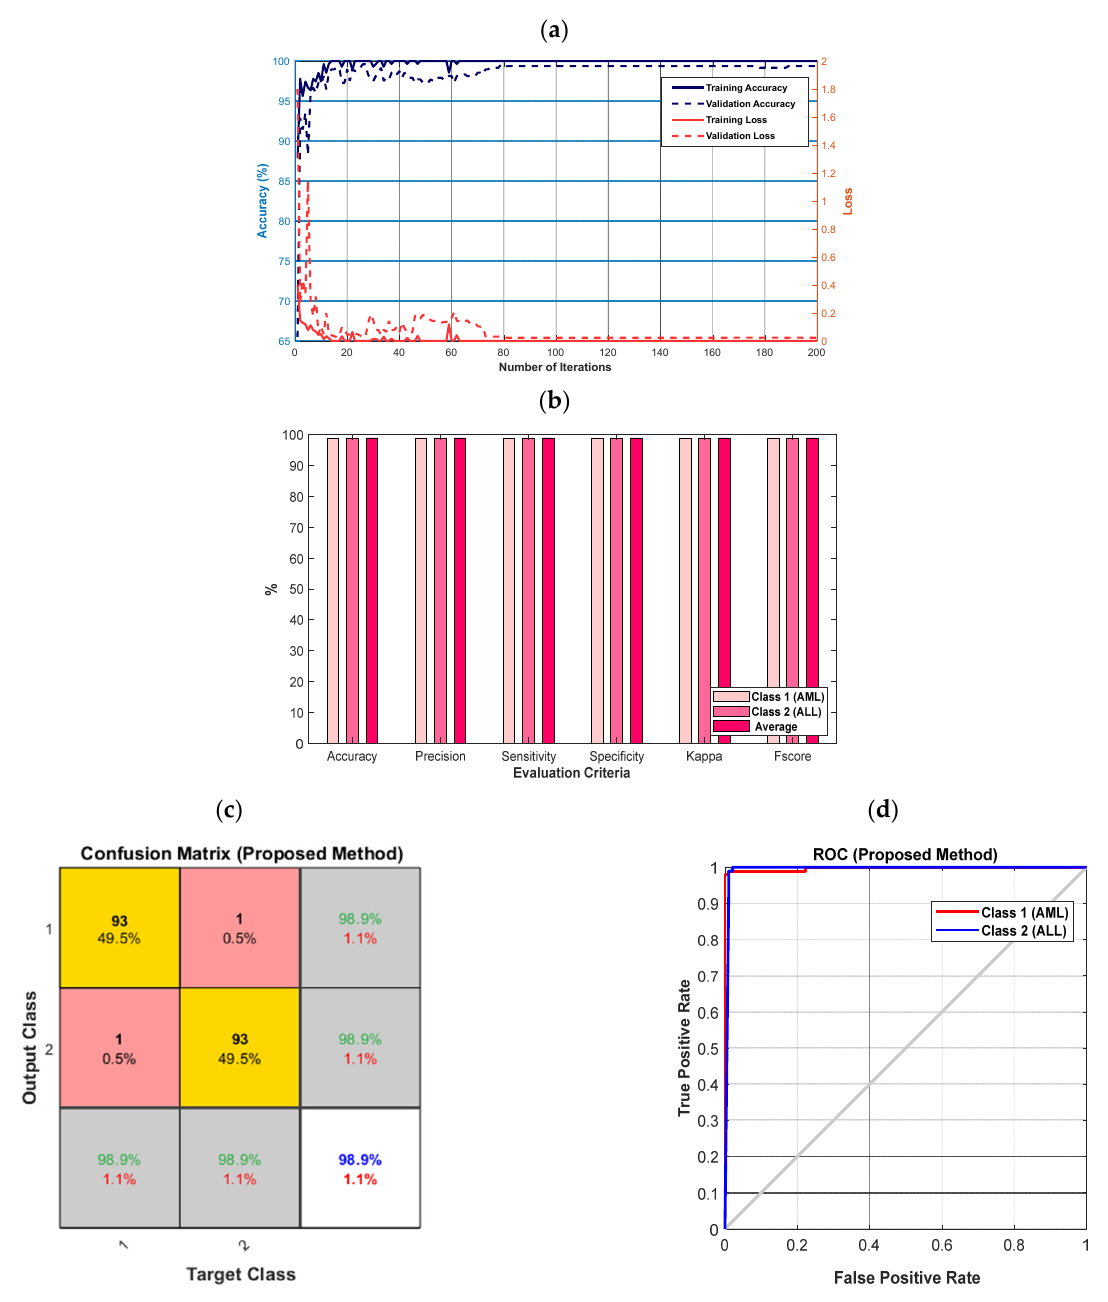
Figure 5. The accuracy and error diagrams of the proposed type-II fuzzy DCNN model (based on training and validation data), as well as the bar chart diagrams of accuracy, precision, sensitivity, specificity, kappa, f-score, confusion matrix, and ROC diagram (based on testing data); ( a ) accuracy and error diagrams, ( b ) bar chart diagram, ( c ) confusion matrix, and ( d ) ROC diagram.